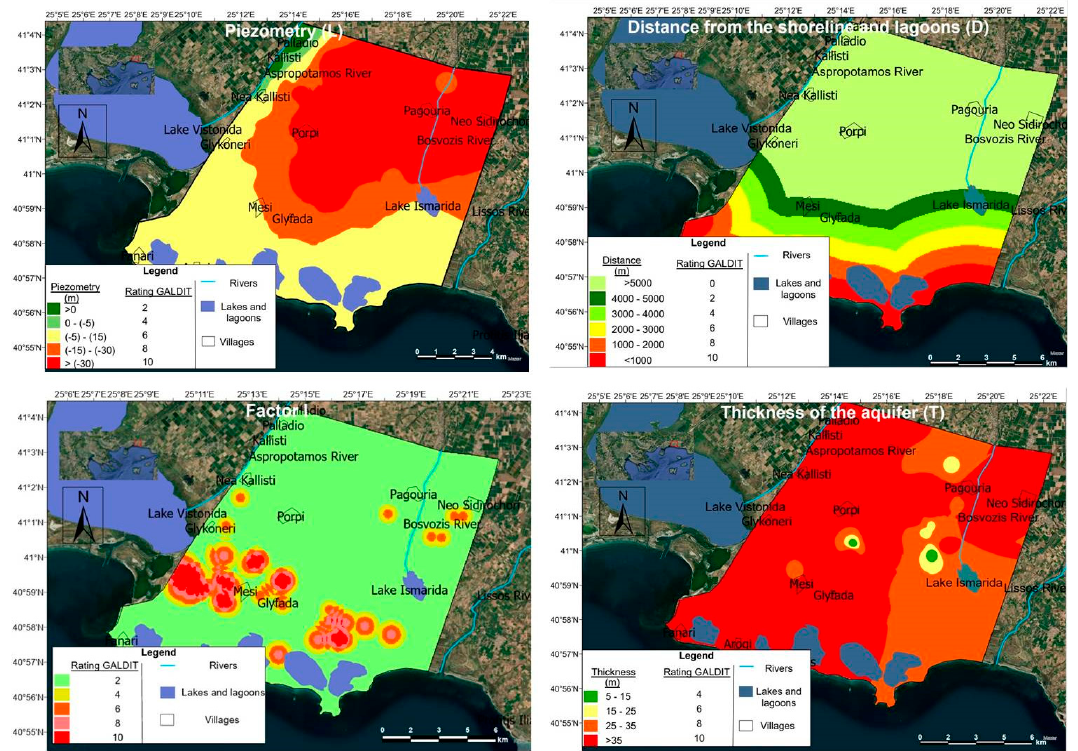
Figure 8. Thematic maps for the groundwater level above sea level (L) ( up left ), distance from the shoreline and lagoons (D) ( up right ), the impact of the existing status of seawater intrusion (I) ( down left ) and thickness of the aquifer (T) ( down right ) for the modified GALDIT method.